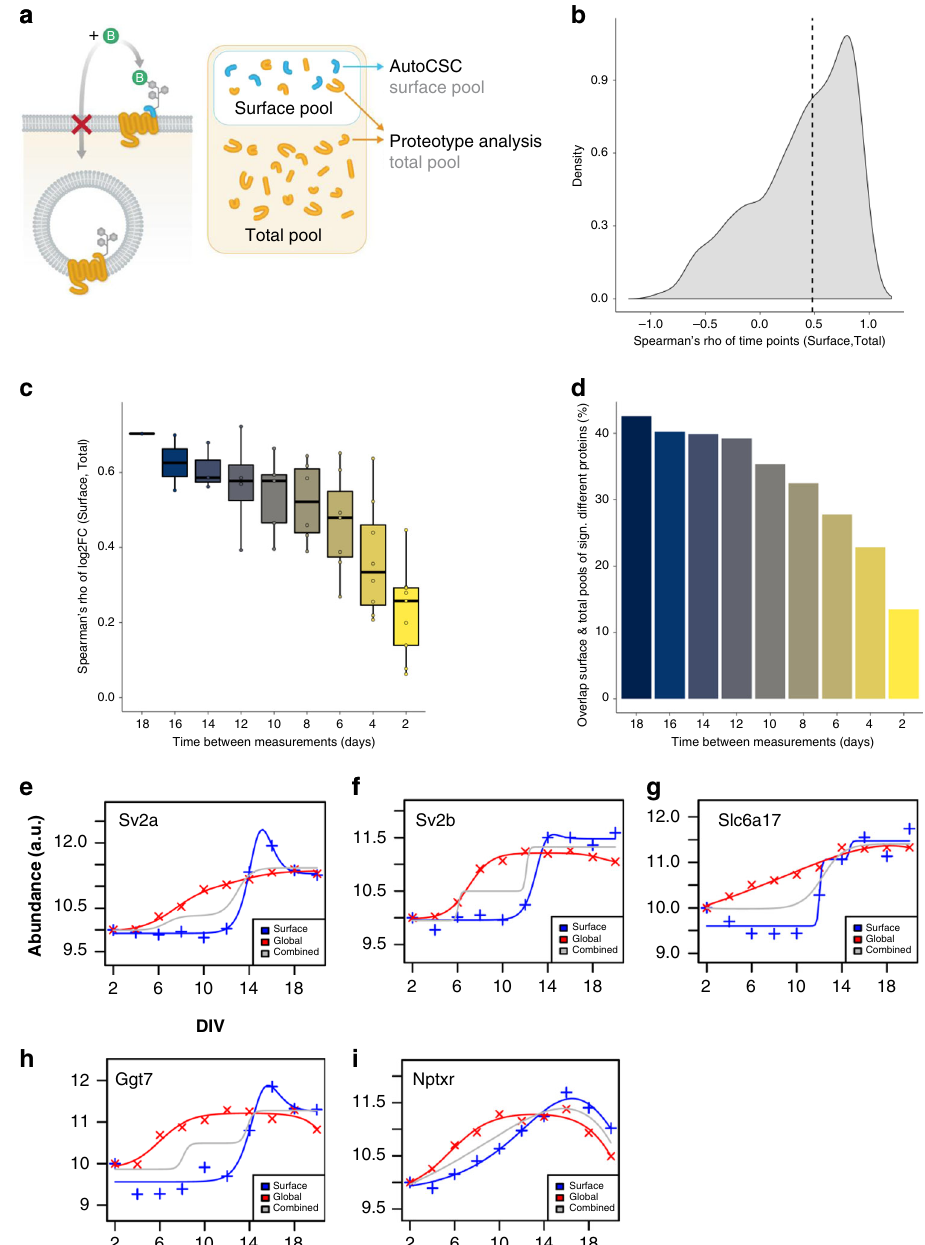
Fig. 4 Correlation of surface with total abundance during differentiation. a Comparison of the surface pool against the total protein pool. Peptides analyzed by autoCSC (blue) are surface exposed and thus speci fi cally report on the acute surface pool. Tryptic peptides from the same samples (orange) report the total protein abundance including both intracellular and surface-localized proteins. b Correlation of surface and total abundance protein pools. Spearman ’ s rho of surface and total abundance time series, median indicated with dashed line. c Boxplots of distribution of Spearman ’ s rho for log2 fold- changes between indicated time intervals for surface and total protein. Boxes indicate median and percentiles (25th and 75th). d Bar chart of counts of overlapping signi fi cantly different proteins (fold-change > 1.5 and p < 0.05) for comparisons between surface and total pools with respect to interval times. e – i Impulse model fi t for data for e Sv2a, f Sv2b, g Slc6a17, h GGt7, and i Nptxr. Crosses indicate the normalized median abundance values of three replicates for each time point for surface (blue) and total (red) pools. Lines indicate impulse model fi ts; gray lines are fi ts to combined data from surface and total pool analyses. Source data are provided as a Source Data fi